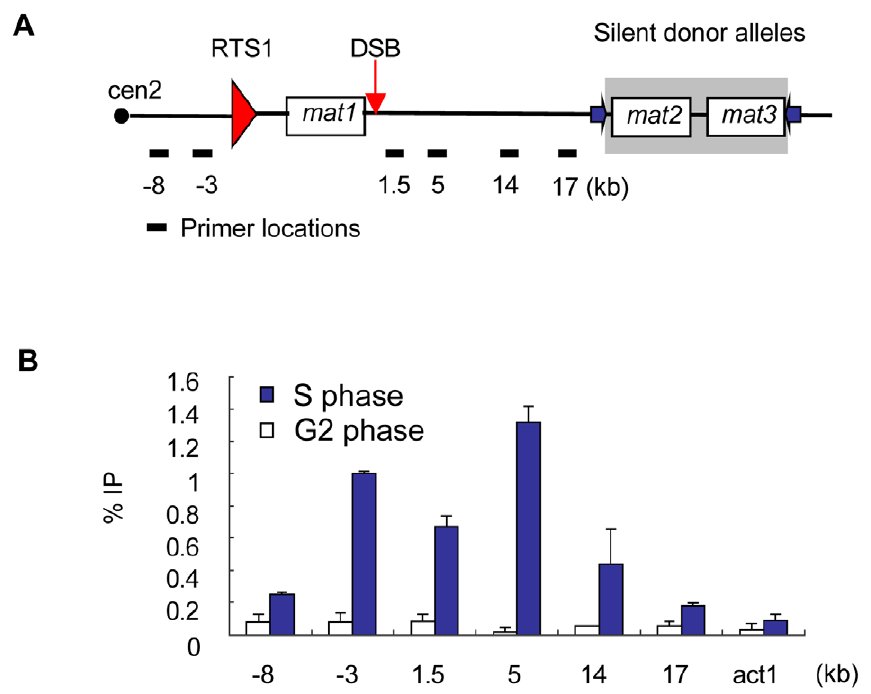
Figure 1. c H2A forms in the mating-type locus during DNA replication. (A) Diagram of a typical S. pombe mating-type (MT) locus (not to scale). Symbols: cen2 –centromere2, RTS1-polar replication fork barrier, DSB- imprinting site where DSB forms during replication; purple arrows - inverted repeats. Primer names correspond to distance in kilobases from the DSB. (B) ChIP-qPCR analysis of c H2A distribution at the MT locus in G2 and S phase. Cells were synchronized in G2 phase using the cdc25-22 allele and S-phase progression was monitored using septation index. ChIP enrichment at the indicated sites was quantitated %IP.